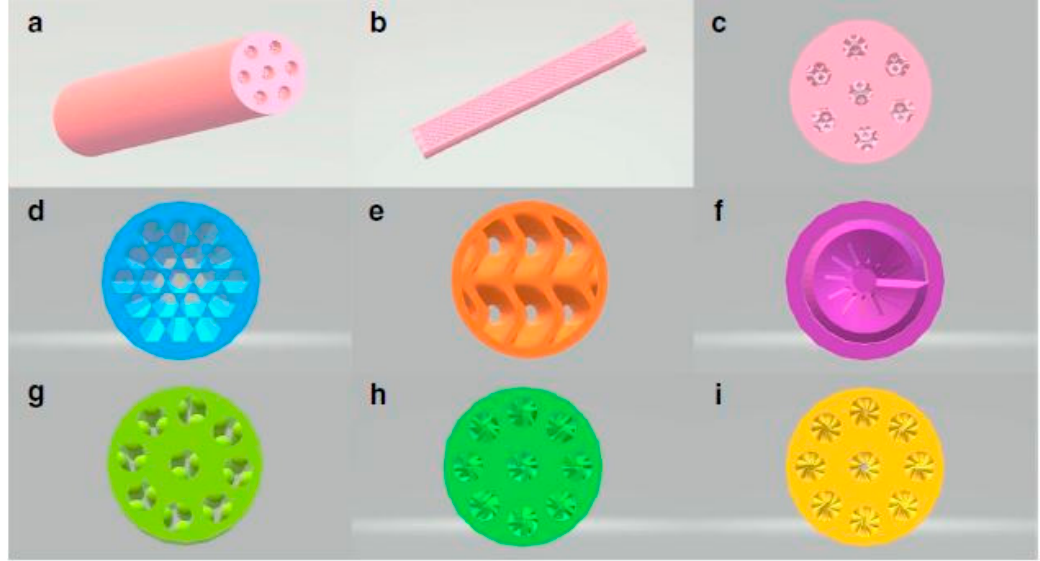
Figure 6. ( a ) Co-self-catalytic reactor (SCR)-1; ( b ) longitudinal section of Co-SCR-1; ( c ) cross-section of Co-SCR-1; ( d ) cross-section of Co-SCR-2; ( e ) cross-section of Co-SCR-3; ( f ) cross-section of Co-SCR-4; ( g ) cross-section of Co-SCR; ( h ) cross-section of Co-SCR-5; ( i ) cross-section of Co-SCR-6 . Reproduced with permission from [130]. Copyright Nature, 2020.